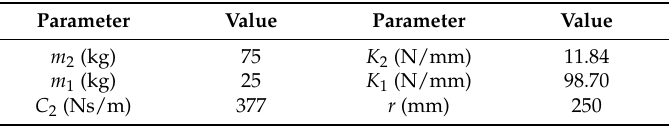
Table 1. The values of the parameters for the human-wheelchair